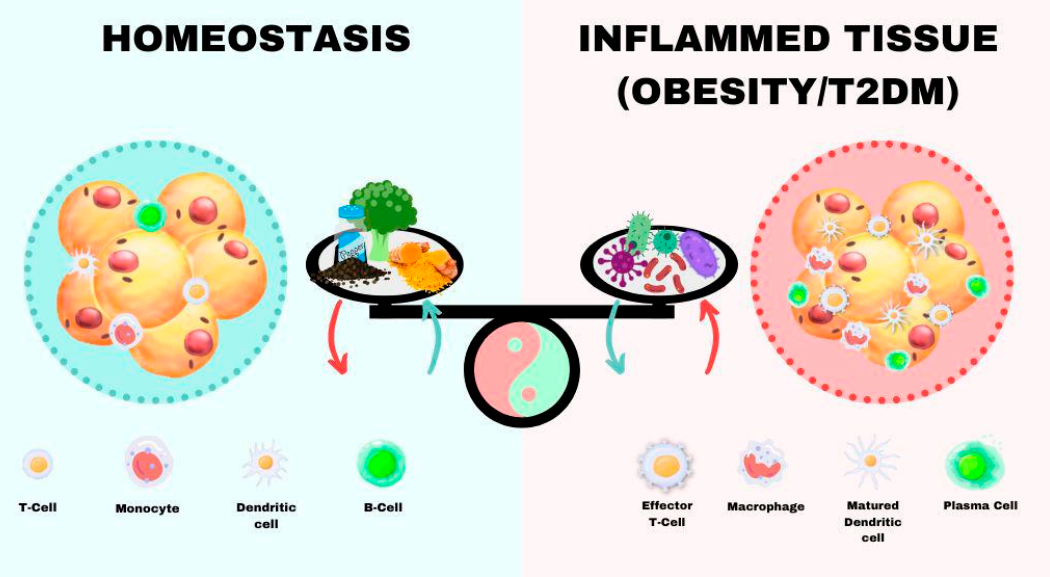
Figure 1. Factors that affect and/or regulate immunometabolism in the tissue microenvironment.